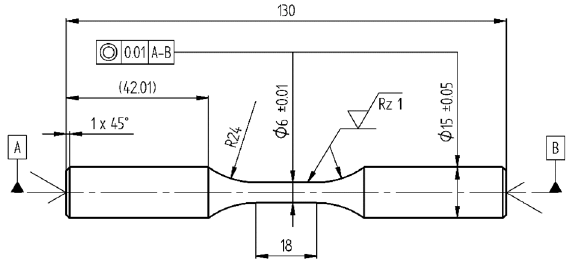
Figure 2. Specimen dimensions (unit: mm). Table 1. Chemical composition of P92 (mass percent, %) measured by spark spectrometry.